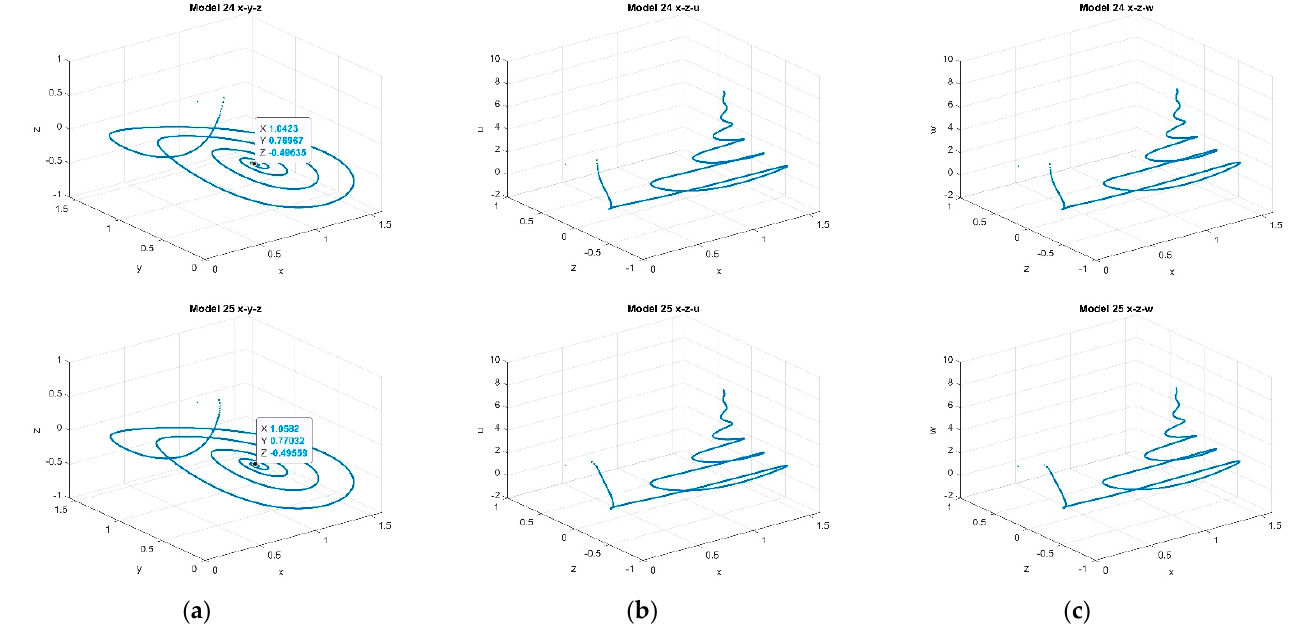
Figure 23. Phase portraits ( a ) x − y − z , ( b ) x − u − z , ( c ) x − z − w , at h = 0.1, k = 2.45, p = 1, α 5 = 0.3 for models (22) through (25).